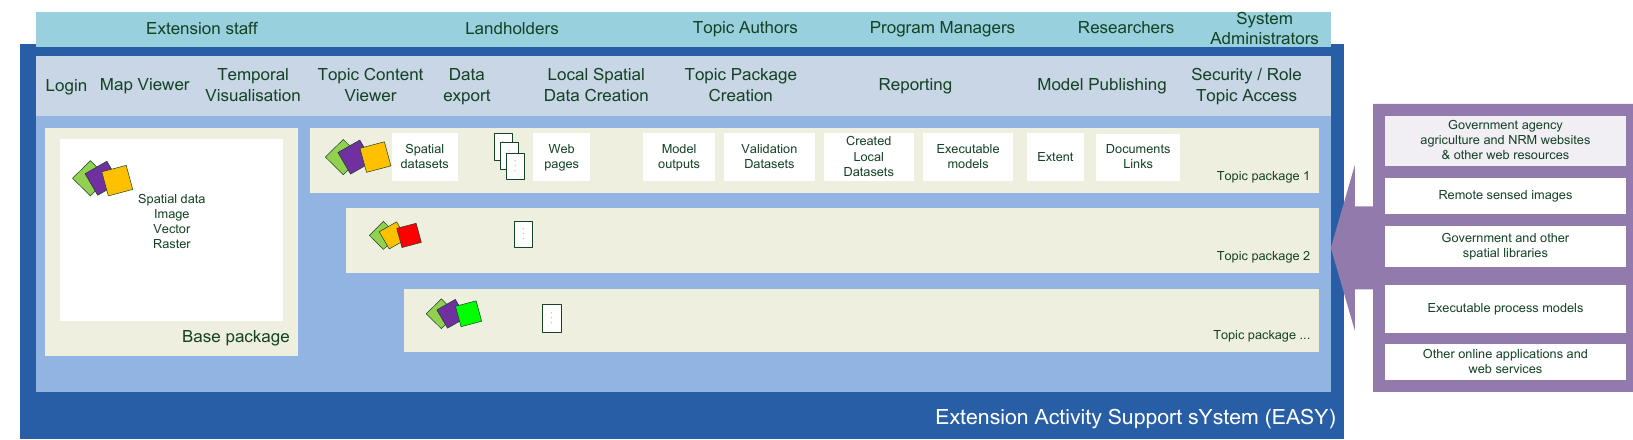
Figure 3. Users, functions, and topic packages in